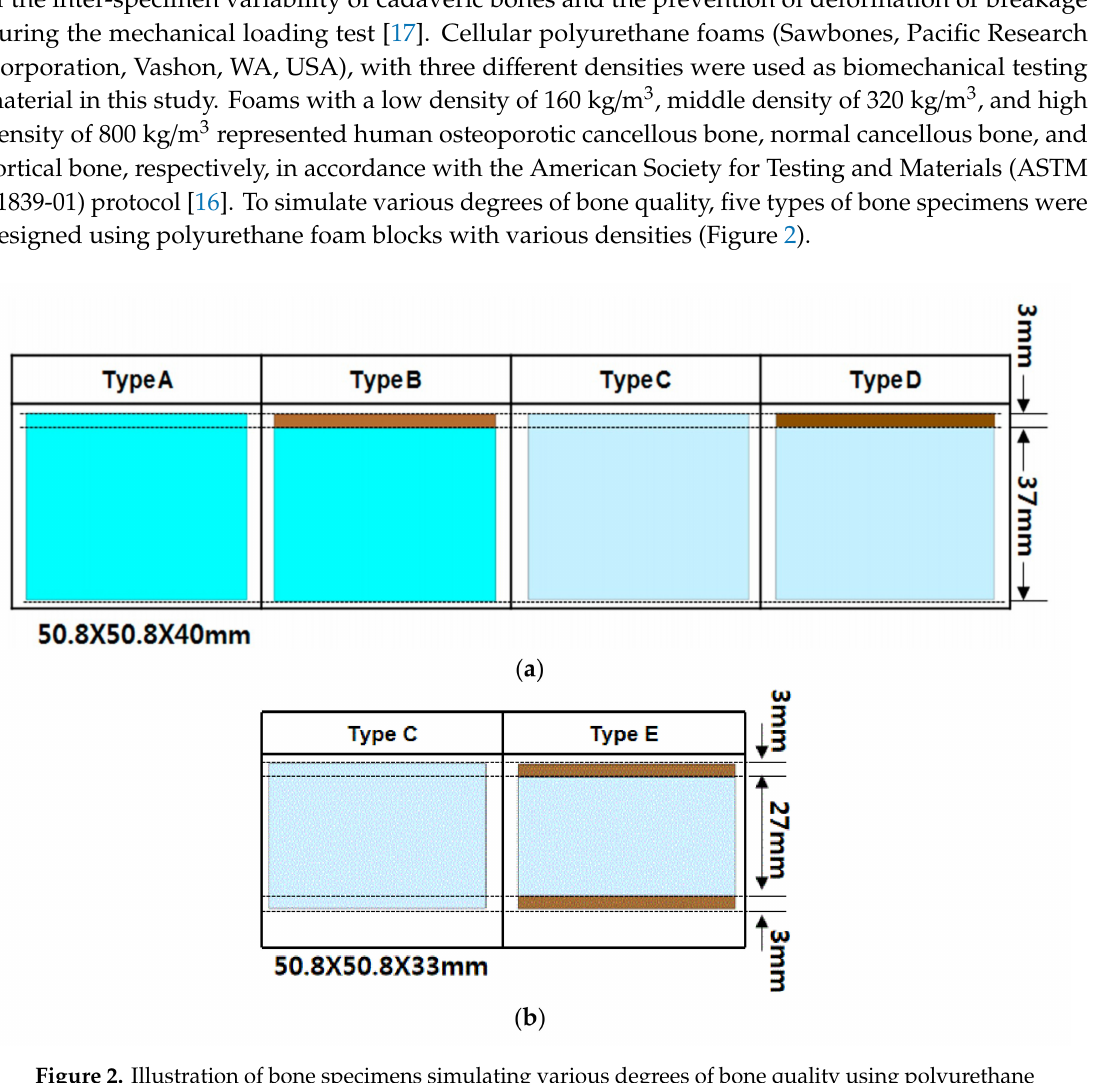
Figure 2. Illustration of bone specimens simulating various degrees of bone quality using polyurethane foam blocks with various densities. ( a ) Type A, B, C and D bone specimens and ( b ) Type C and E bone